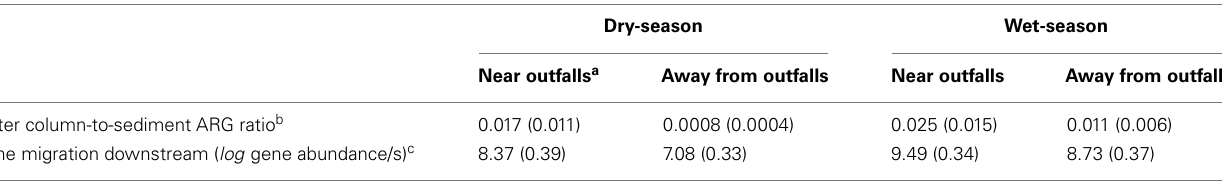
Table 3 | Comparison of water column-to-sedimentARG ratios andARG flux in the dry-season and wet-season for sampling near and away from major waste outfalls into the